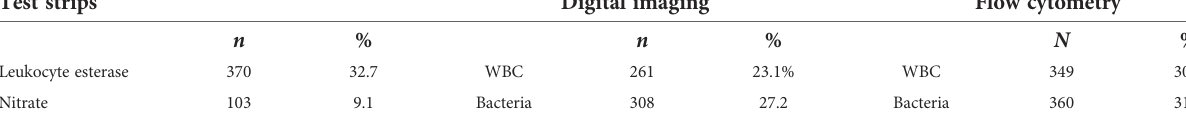
TABLE 4 Urine positive test results in the different methods of urine measurement.